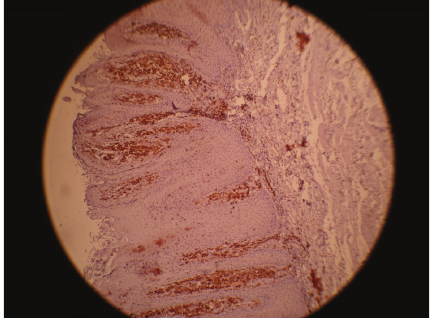
Figure 2: Showing epithelial hyperplasia with parakeratosis and elongated rete pegs. There is an abundance of foam cells in the connective tissue papilla (H&E stain 10x).